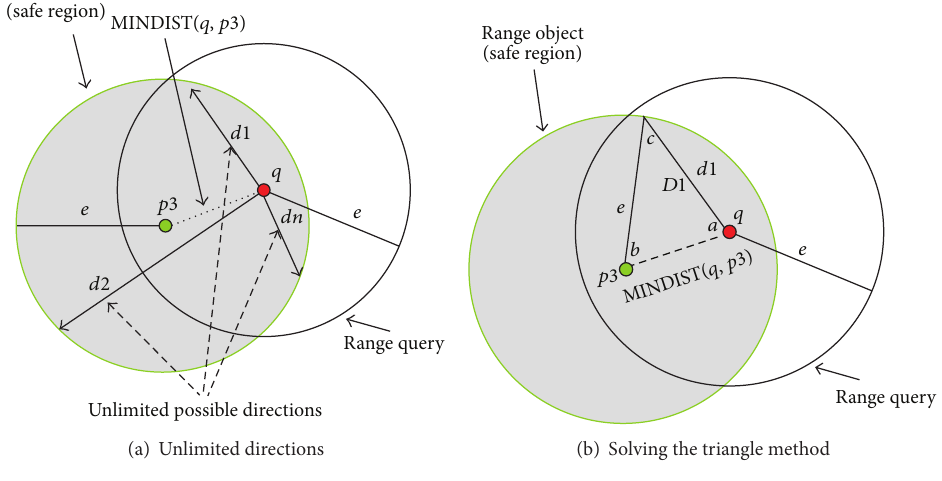
Figure 5: Safe region using linear function.